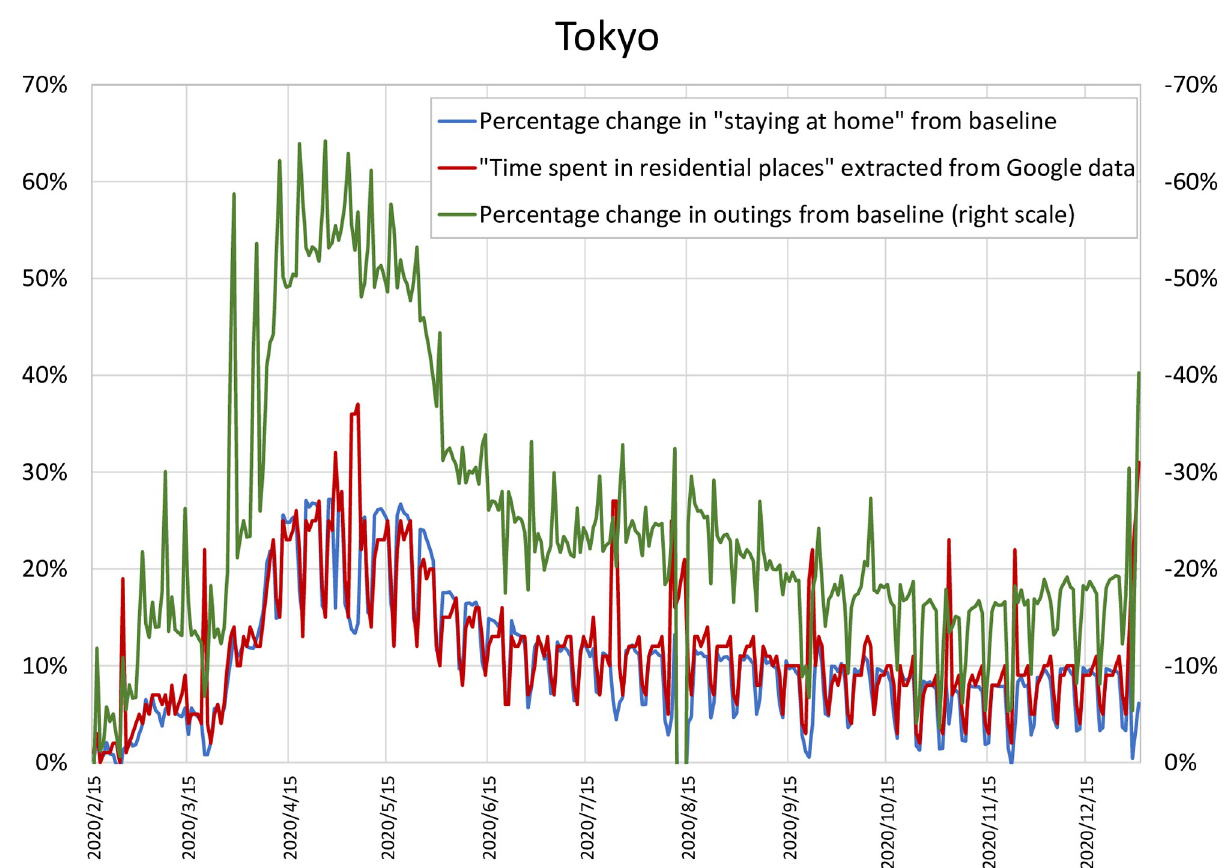
Fig 3. Our Measures and Google’s mobility measure. The blue line shows the percentage change in the level of outings from the corresponding value at the baseline, where the level of outings is defined as the difference between the nighttime and the daytime population. The green line shows the percentage change in the extent to which people stayed at home, which is defined as the daytime population, from the corresponding value at the baseline. Both are constructed from the DoCoMo data. The red line shows the measure of “time spent in residential places” extracted from Google’s Community Mobility